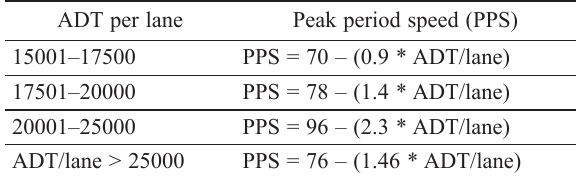
Table 2. Peak period speed